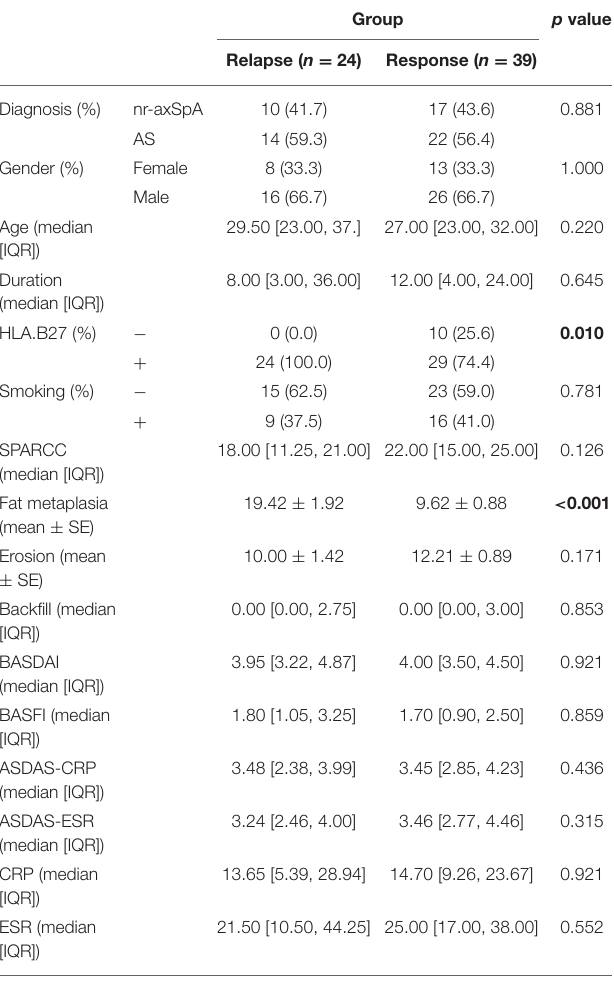
TABLE 3 | Baseline data between patients relapsed or not before the average DQ < 25 in the tapering group. Group p